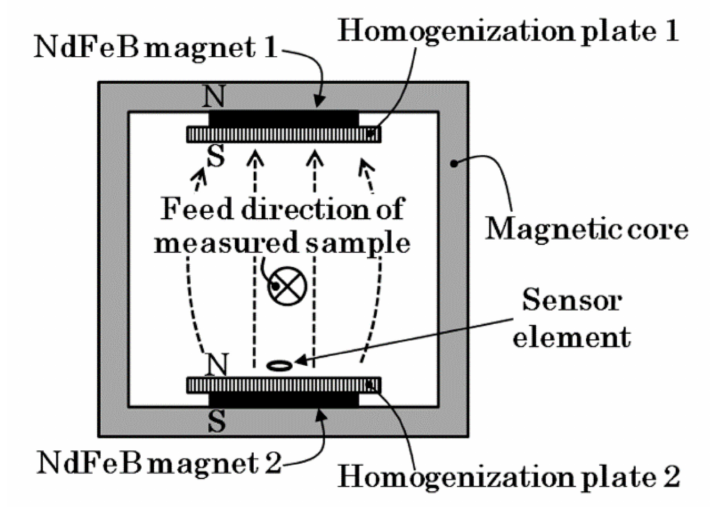
Figure 1. Schematic image of proposed inspection system. (The dotted arrow explains a generated magnetic